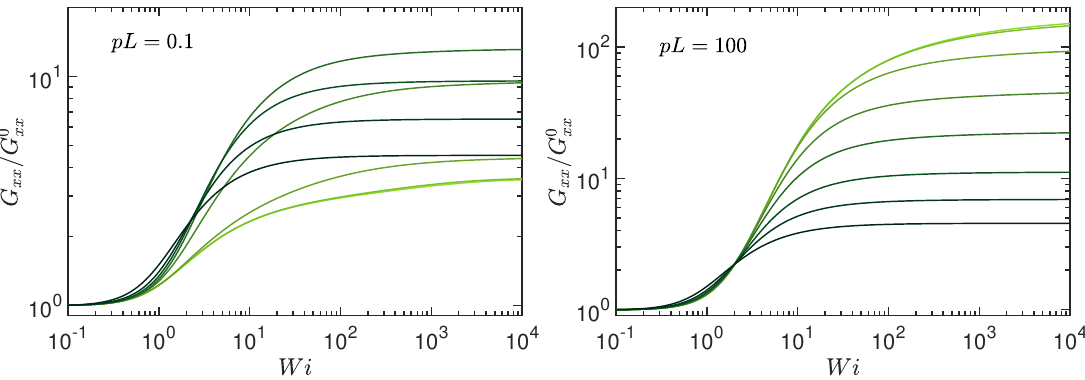
Figure 6. Radius of gyration-tensor component G xx along the flow direction normalized by the value G 0 xx at zero shear as function of the Weissenberg number Wi for the Péclet numbers Pe = 0, 0.6, 3, 10, 30, 10 2 ,3 × 10 2 , and ∞ (bright to dark color); ( left ) pL = 0.1 and ( right ) pL = 10 2 . The number of active sites is L / l = 10 2 and ∆ = 0.3.